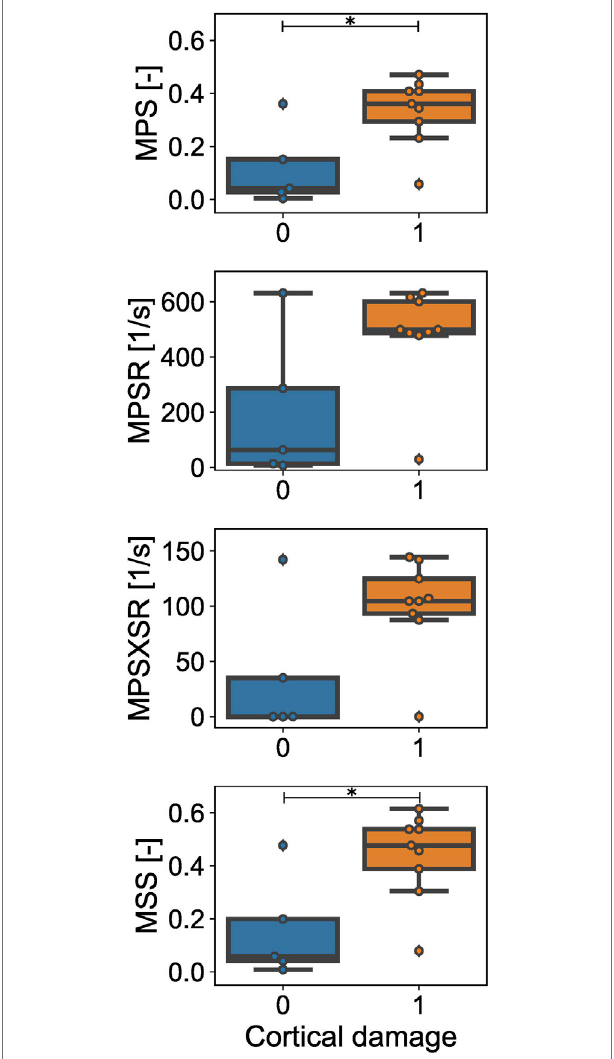
FIGURE 6 | Estimated values of the injury metrics for the CCI injury (orange) vs. no injury (blue) cases. Maximum principal strain (MPS) and maximum shear strain (MSS) are different for cases with observed cortical damage vs. no damage. No statistical difference is observed in terms of maximum principal strain rate (MPSR) and maximum principal strain x strain rate (MPSXSR) between injury and no injury cases. * (cid:1) p -value < 0.05.